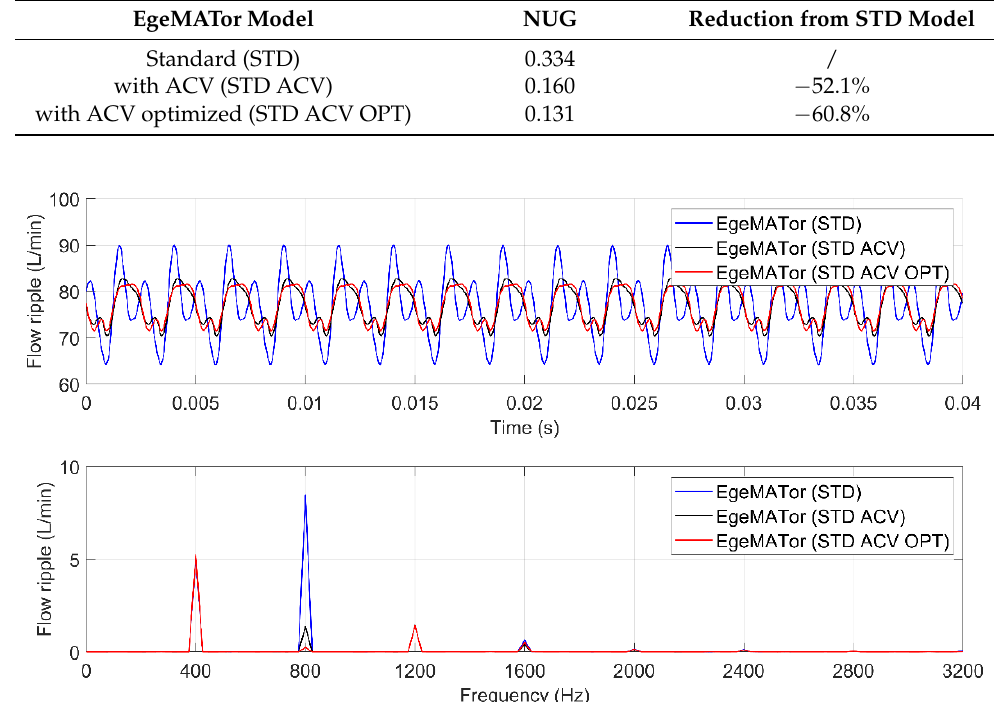
Table 1. Results summary at 1500 rev/min and 230 bar.